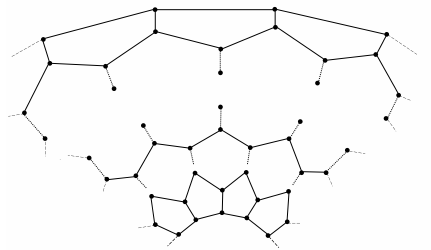
Figure 6. Extension of the graph Dn